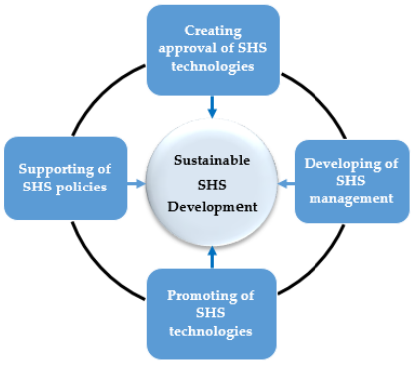
Figure 7. Framework of development strategy for sustainable SHS.